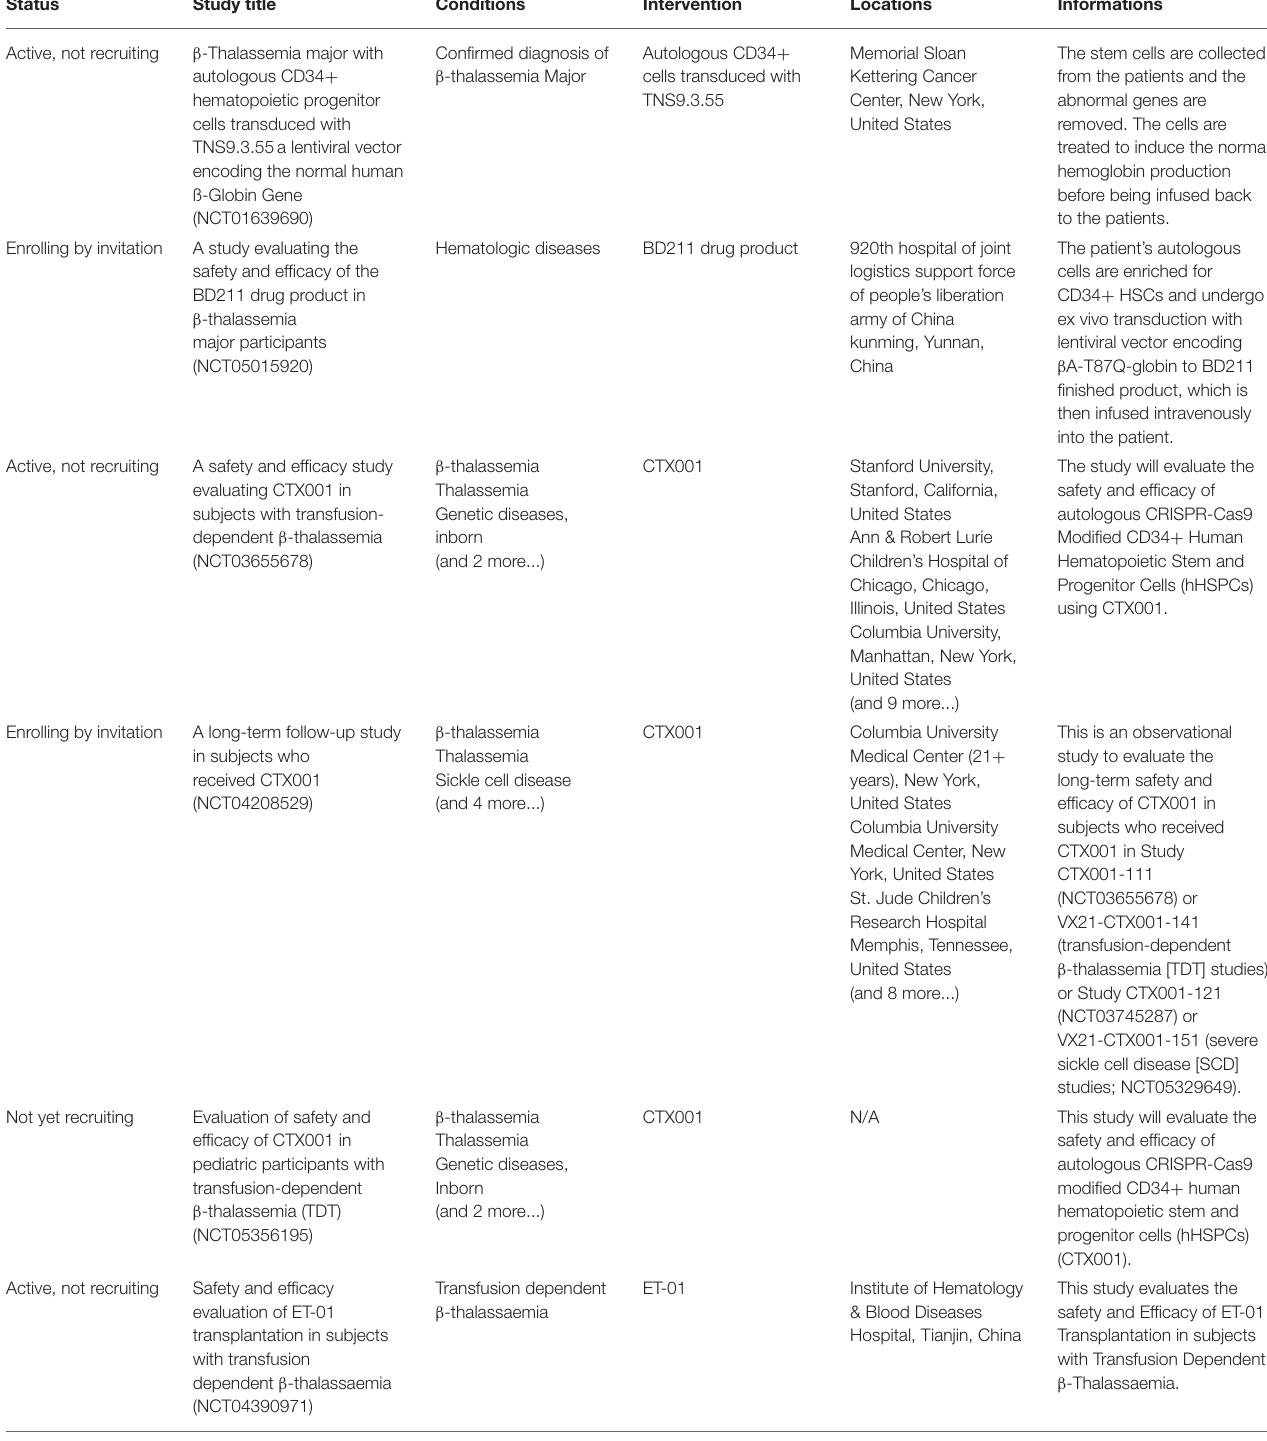
TABLE 2 | Clinical trials using the CRISPR-mediated technology